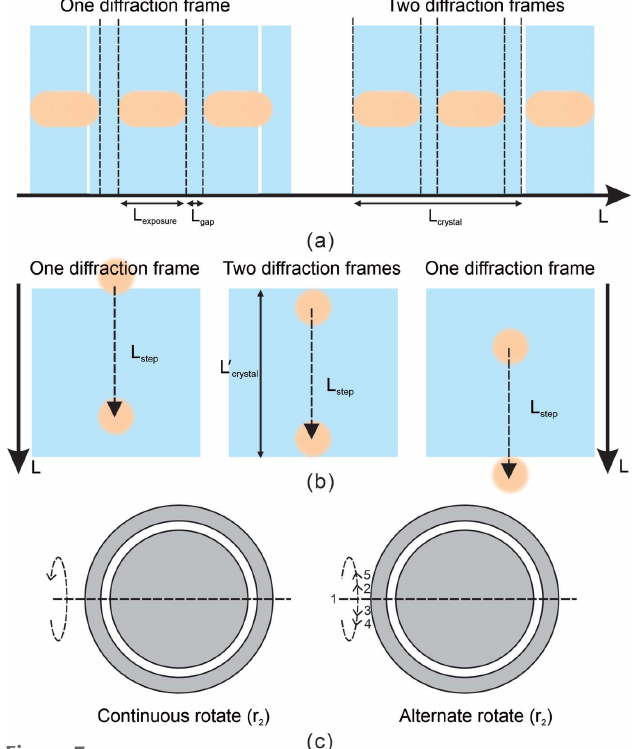
Figure 7 Recommended sample delivery speed, step length and rotational ( r 2 ) mode. ( a ) Recommended sample delivery speed. L crystal is the size of the crystal in the delivery direction, L exposure is the distance of the crystal delivery during exposure, and L gap is the distance of the crystal delivery during the delay time for the detector collecting data. ( b ) Recommended step length. L 0 is the size of the crystal in the translation direction, and crystal L step is the translation step length. ( c ) Recommended rotational ( r 2 ) modes, including continuous rotation in one direction and alternating rotation in two